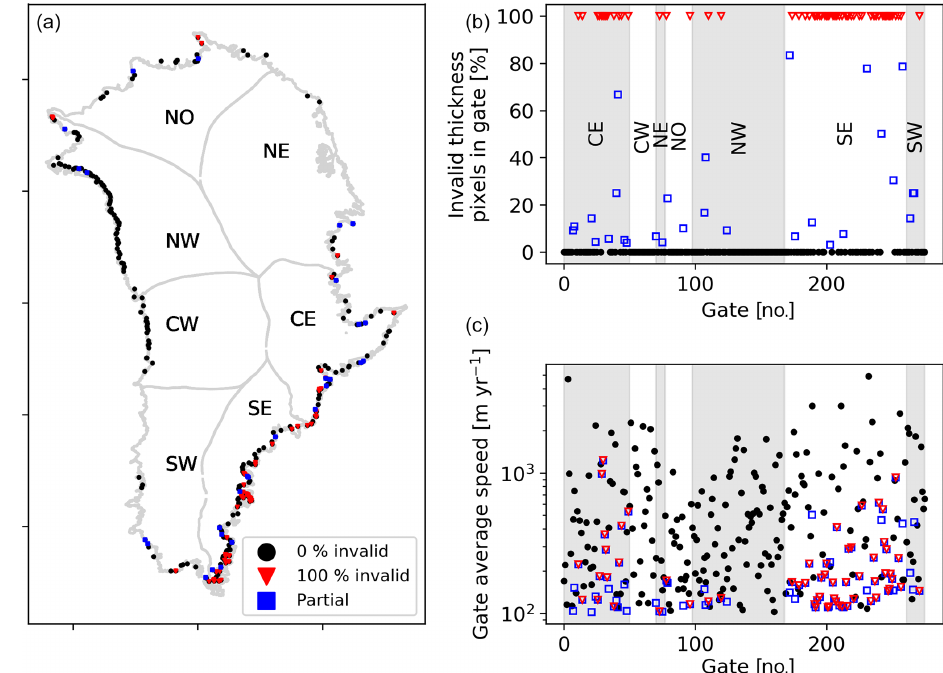
Figure A1. Gate locations and thickness quality. (a) Locations of all gates. Black dots represent gates with 100% valid thickness pixels, blue with partial, and red with none. (b) Percent of bad pixels in each of the 276 gates, arranged by region. (c) Average speed of gates. Color same as panel (a) .